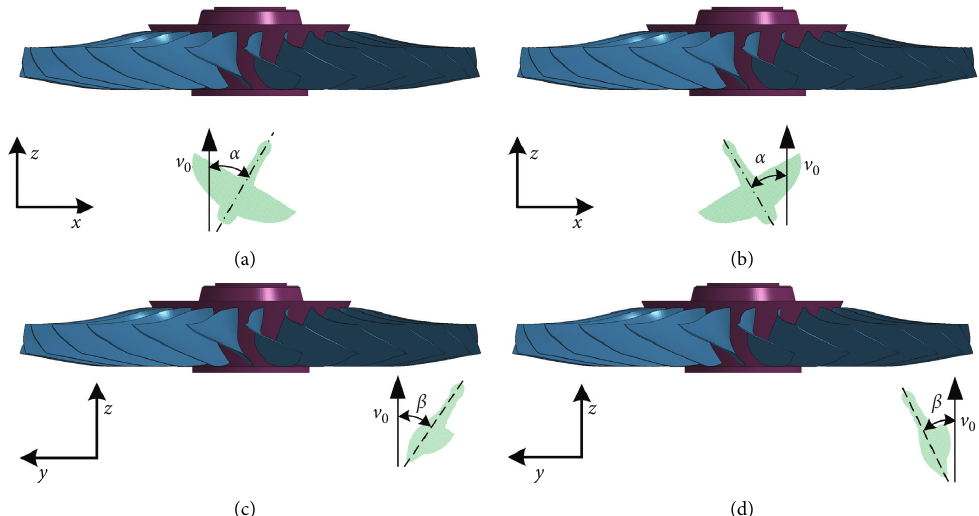
Figure 6: Schematic of yaw and pitch angles. (a) Positive yaw angle α . (b) Negative yaw angle α . (c) Positive pitch angle β . (d) Negative pitch angle β .